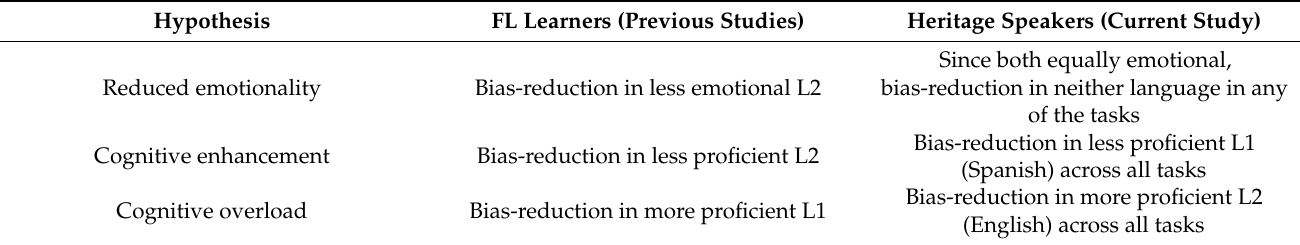
Table 2. Hypotheses regarding the Foreign Language Effect